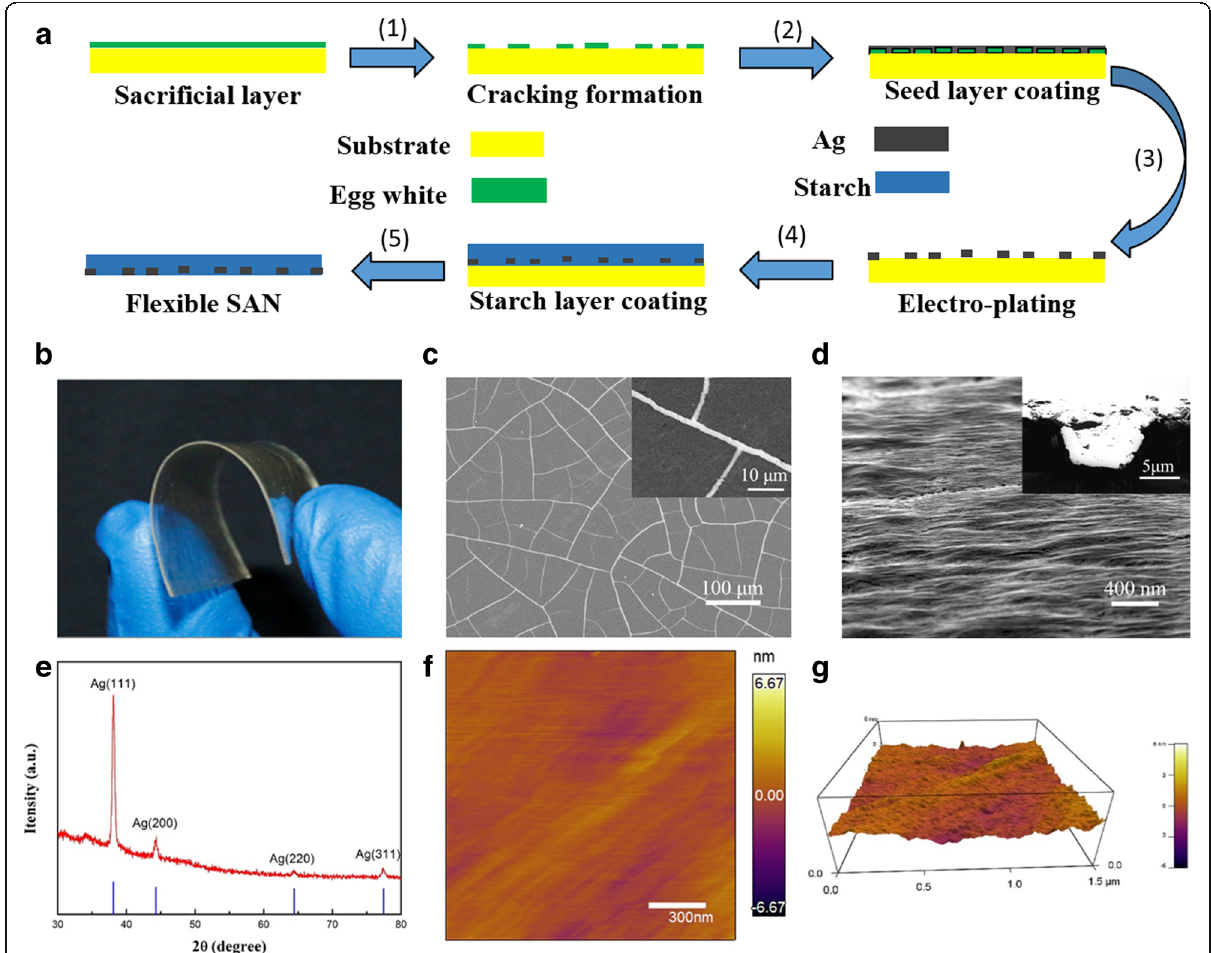
Fig. 1 Fabrications and characterizations of SAN samples. a Fabrication processes. b Flexibility demonstration of a SAN sample. c SEM images. Inset shows an enlarged metallic network. d Tilted (60°) SEM image of the embedded Ag networks. Inset is the cross-sectional view of the Ag network. e XRD spectra. f , g AFM images of the surface